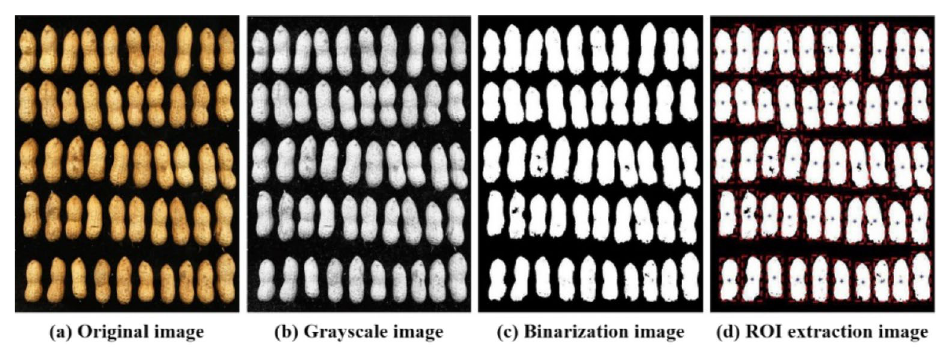
Figure 2. The workflow of peanut image